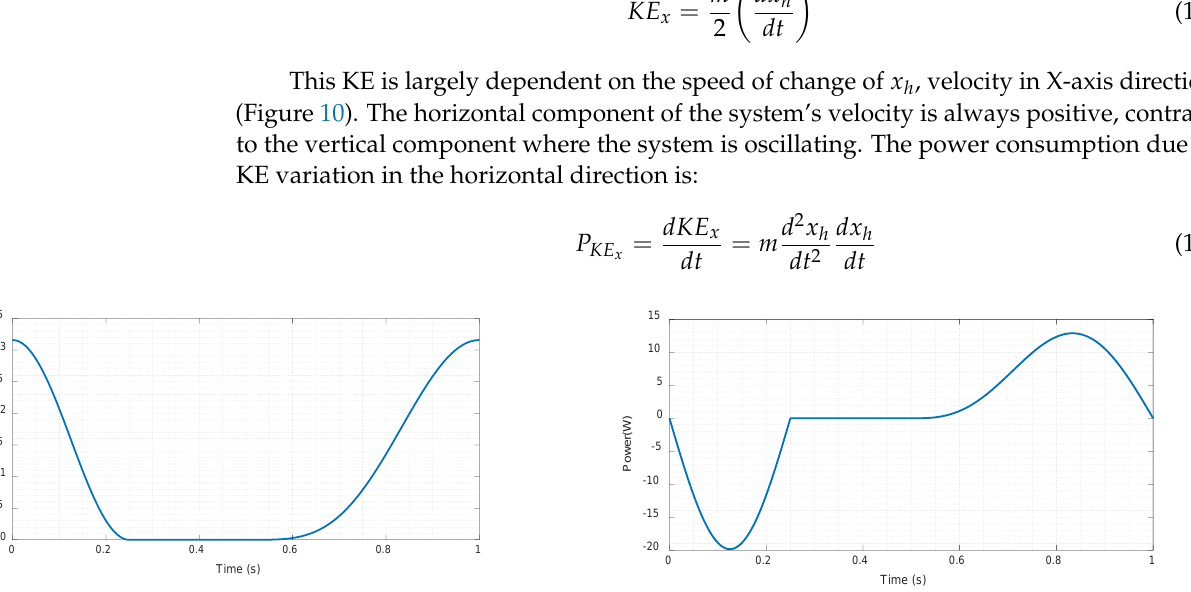
Figure 9. Kinetic energy in the Y-axis of the system with w = 60 rpm, m = 1 kg and r = 0.2 m ( left ), and power consumption associated with kinetic energy variation, m = 1 kg, w = 60 rpm, r = 0.2 m ( right ).